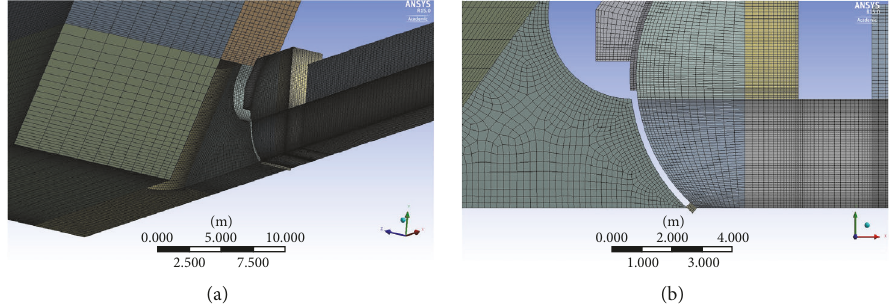
Figure 4: Numerical grid. (a) An overall view; (b) locally at the radial gate, with the gate at the closed